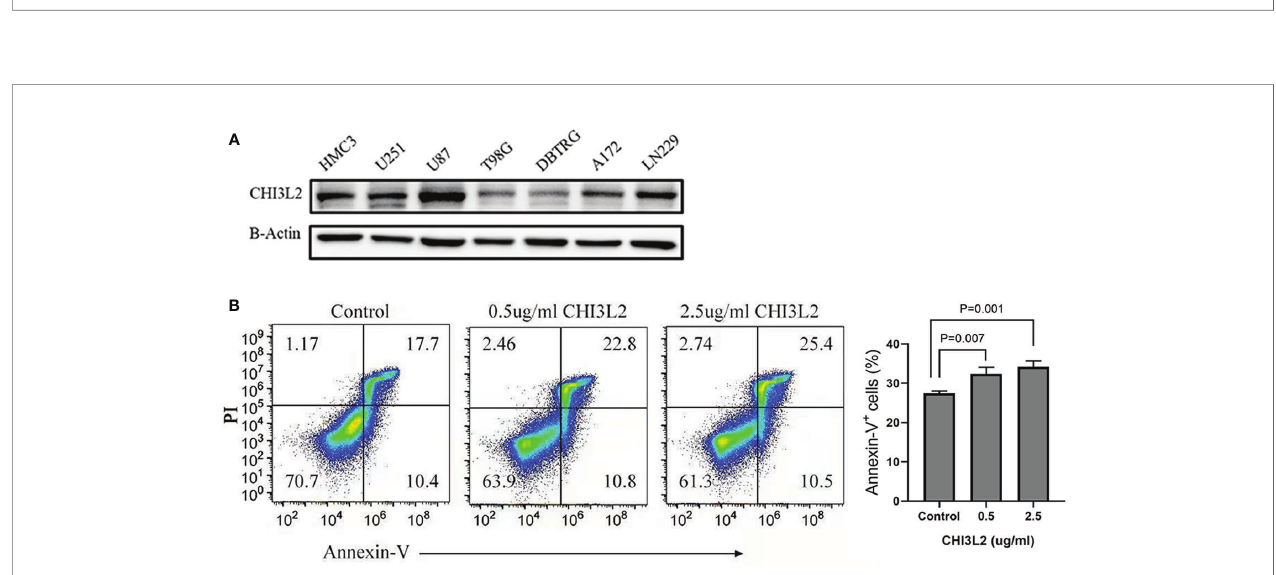
FIGURE 8 | The expression of CHI3L2 was veri fi ed by Western Blot and the proportion of CD8+ T cell apoptosis was analyzed by fl ow cytometry. (A) Western blot of seven human glioma cell lines and one human microglia cell line (HMC3) reveals robust CHI3L2 protein expression. (B) CD8+ T cells were cultured with 10% serum media and treated with or without CHI3L2 for 72 hours. Cell apoptosis was analyzed by using FITC-annexin V-based fl ow cytometry, the cellular apoptotic rate was a sum of early and late apoptotic rates. Left, the representative sorting. Right, quanti fi ed result of three independent